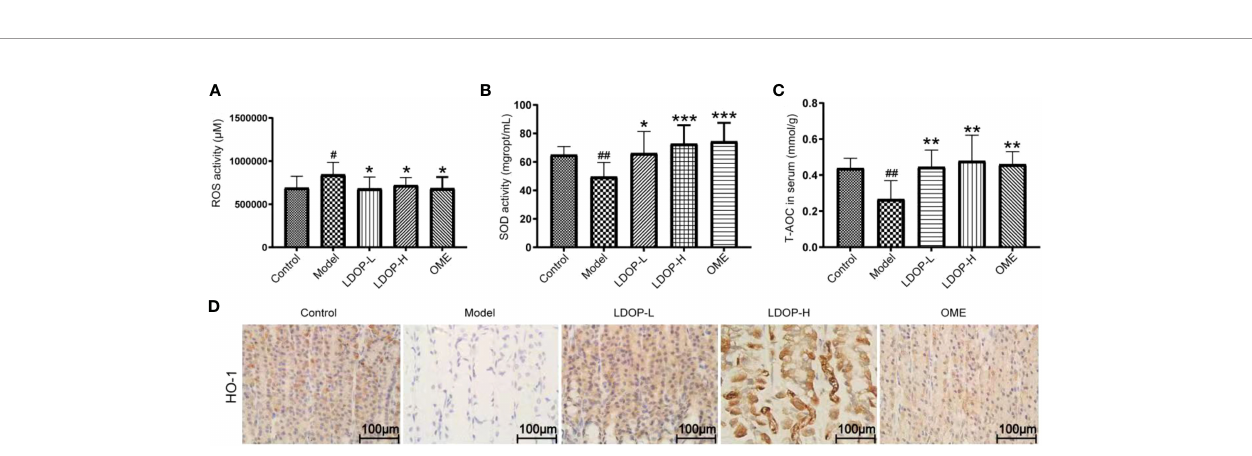
FIGURE 4 | Effects of LDOP-1 on oxidative stress. ROS (A) , SOD (B) and T-AOC (C) were measured by biochemical Assays and the expression of HO-1 (D) was examined by immunohistochemical analysis (400×, brown yellow granules indicate positive reaction). Data are expressed as the mean±SD of three independent experiments. # P<0.05, ## P<0.01 compare the control group; *P<0.05 and **P<0.01, ***P < 0.001 compare model group. LDOP-L stood for LDOP-1-L, LDOP-H stood for